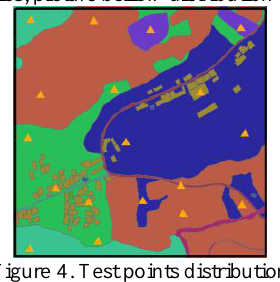
Figure 4. Test points distribution